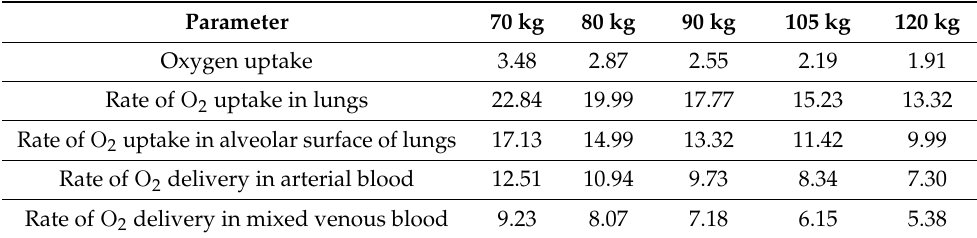
Table 1. Rates of oxygen uptake and its supply at every stage of its delivery in mL/min per 1 kg of body mass (mL/min · kg − 1